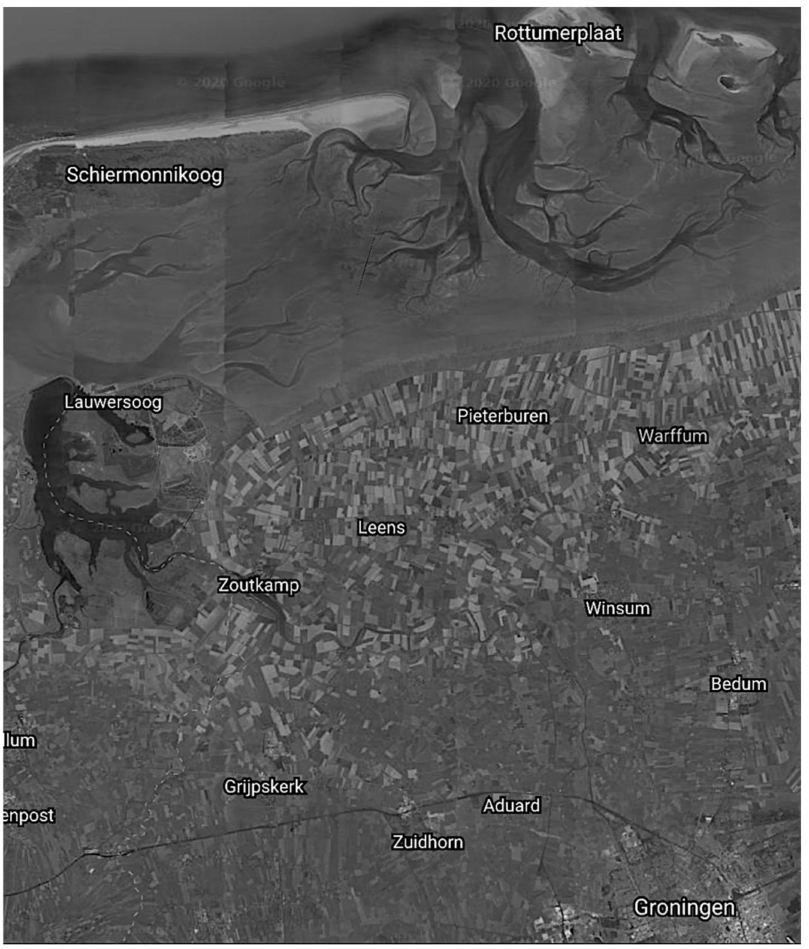
Figure 1. The northern Groningen